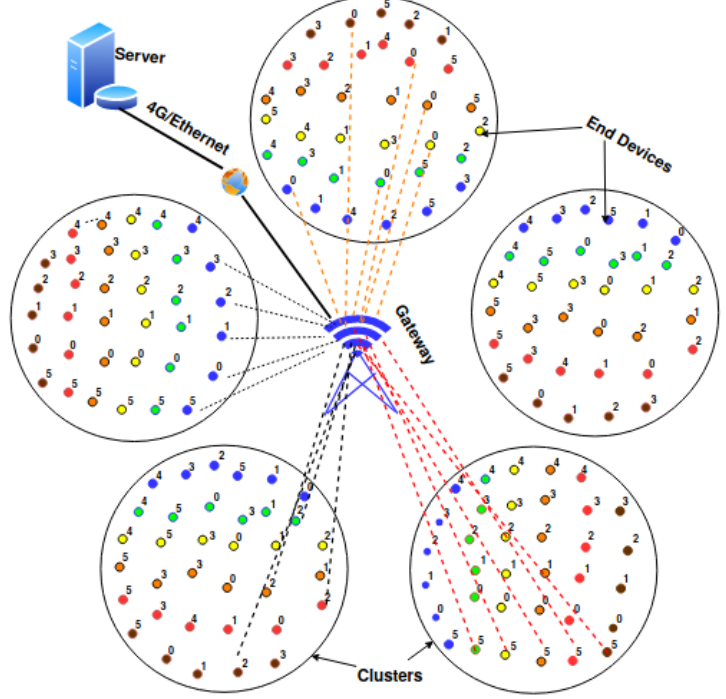
Figure 1. General network architecture with 5 clusters in the monitoring